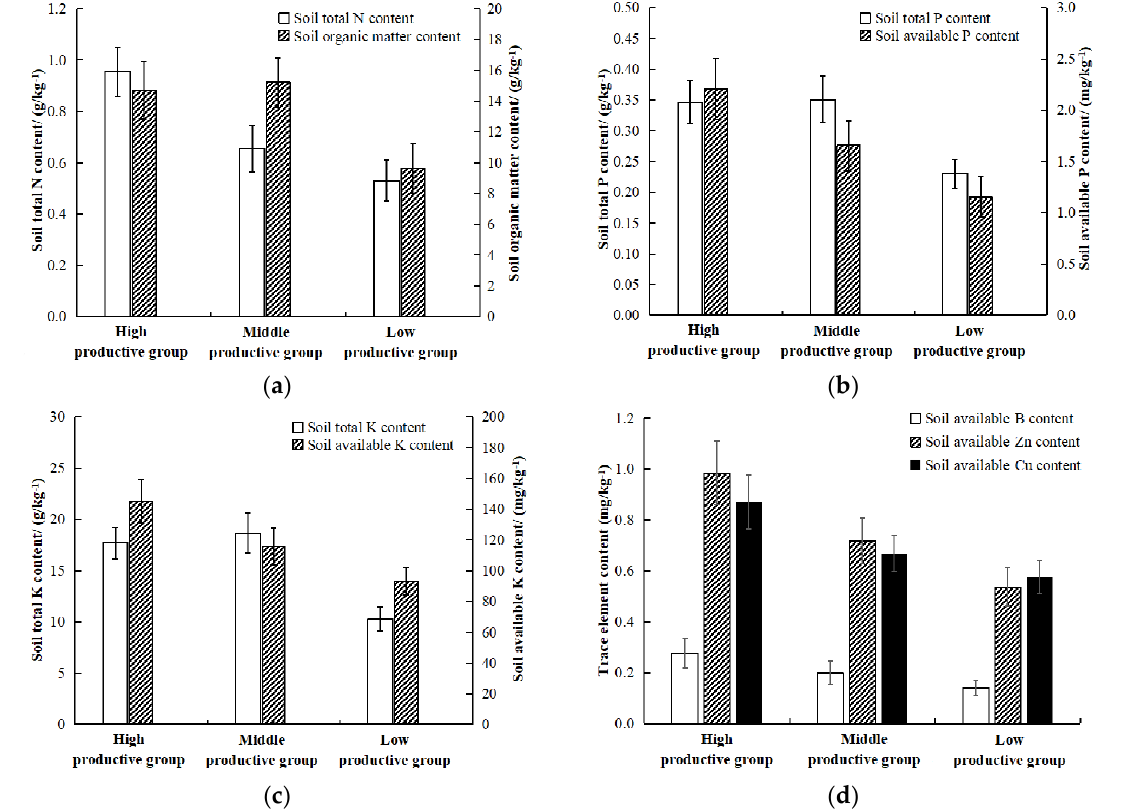
Figure 3. Main chemical and physical properties for each productivity group. ( a ) Performance of soil total N content and soil organic matter content under different productivity group, ( b ) Performance of soil total P content and soil available P content under different productivity group, ( c ) Performance of soil total K content and soil available K content under different productivity group, ( d ) Performance of soil available B content, soil available Zn content and soil available Cu content under different productivity group.